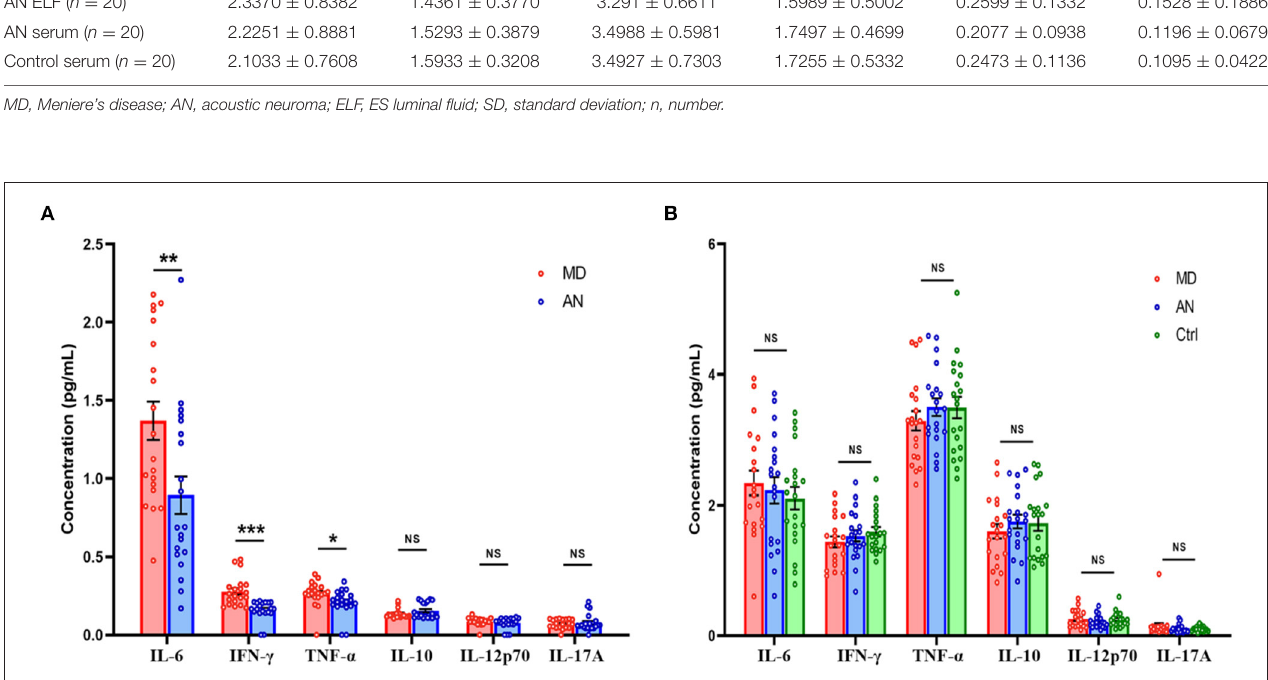
FIGURE 3 | (A) Cytokine levels of ELF in the MD group compared with those in the AN group. (B) Cytokine levels of the serum in the MD group compared with those in the AN group and the healthy control group. * P < 0.05; ** P < 0.01; *** P < 0.001; ES, endolymphatic sac; ELF, ES luminal fluid; MD, Meniere’s disease; AN, acoustic